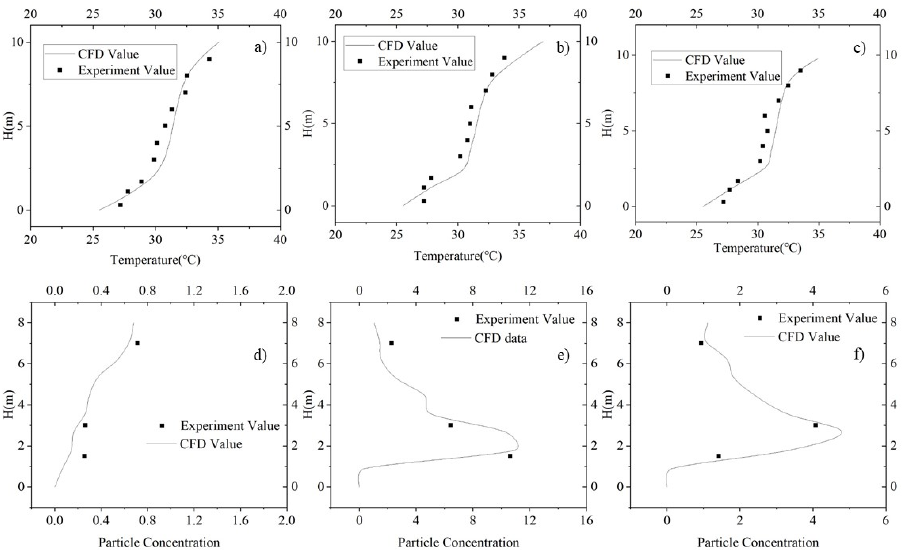
Figure 3. Comparison of CFD and experimental temperature and particle concentration data: ( a ) CFD and experimental temperature data for test line 1, ( b ) CFD and experimental temperature data for test line 2, ( c ) CFD and experimental temperature data for test line 3, ( d ) CFD and experimental particle concentration data for test line 1, ( e ) CFD and experimental particle concentration data for line 2, and ( f ) CFD and experimental particle concentration data for line 3.